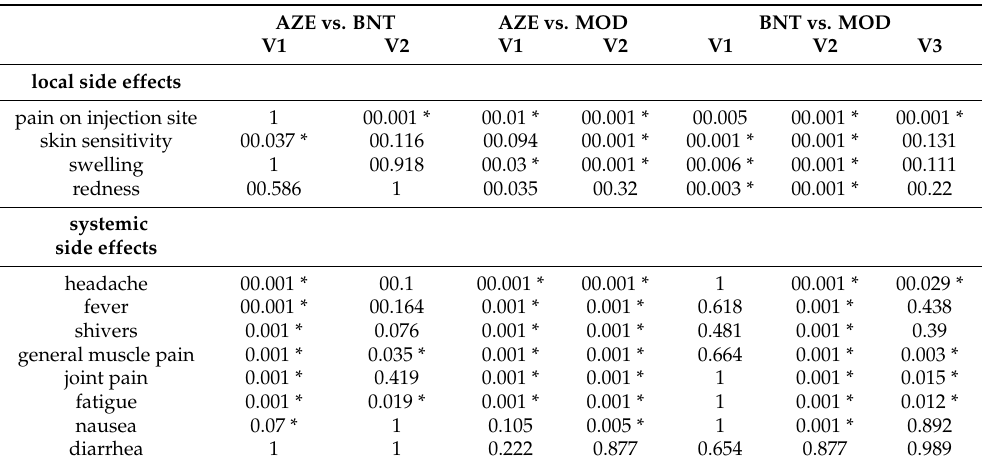
p -values for the comparison of different vaccines in terms of side effect frequency and severity. A Chi-square test has been performed for the administered vaccine on first vaccination and the proportion of each reported side effect. p -values were adjusted with the Bonferroni correction (6 × ). Asterisks indicate statistical significance. (AZE: AstraZeneca (ChAdOx1 nCov19); BNT: Biontech/Pfizer (BNT162b2); MOD: Moderna (mRNA-1273)). The distribution of local side effects according to symptom severity is presented in Figure 1. Compared to AZE, the severity of local side effects, except for skin sensitivity and diarrhea, was significantly higher after vaccination with MOD (Table 3). However, the severity of most local side effects was similar after receiving AZE and BNT vaccines after the first vaccination (Table 3). On the other hand, the severity of most of the local side effects was higher after MOD compared to BNT (Table 3). Table 3. Comparison of side effects in terms of symptom severity after different vaccines. AZE vs.